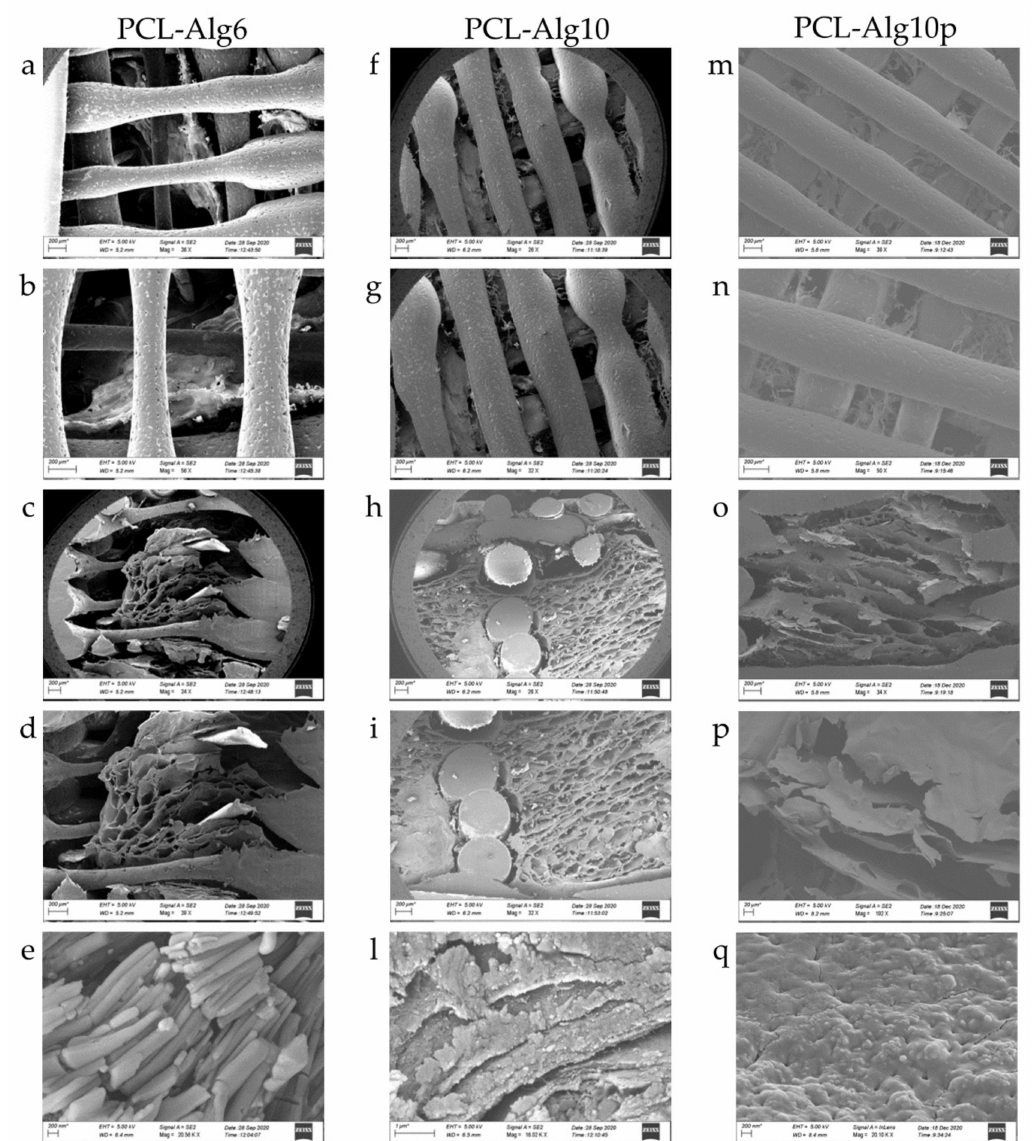
Figure 6. Morphological investigation by SEM of PCL-Alg6, PCL-Alg10, and PCL-Alg10p scaffolds before drug release studies ( a–d , f–i and m–p ). Higher magnifications of the bioink surface are also reported ( e , l , q ) to highlight the vesicular component of the lyosecretome. Scale bar: 200 µ m for ( a–i , m–o and q ); 1 µ m for ( l ); 20 µ m for ( p